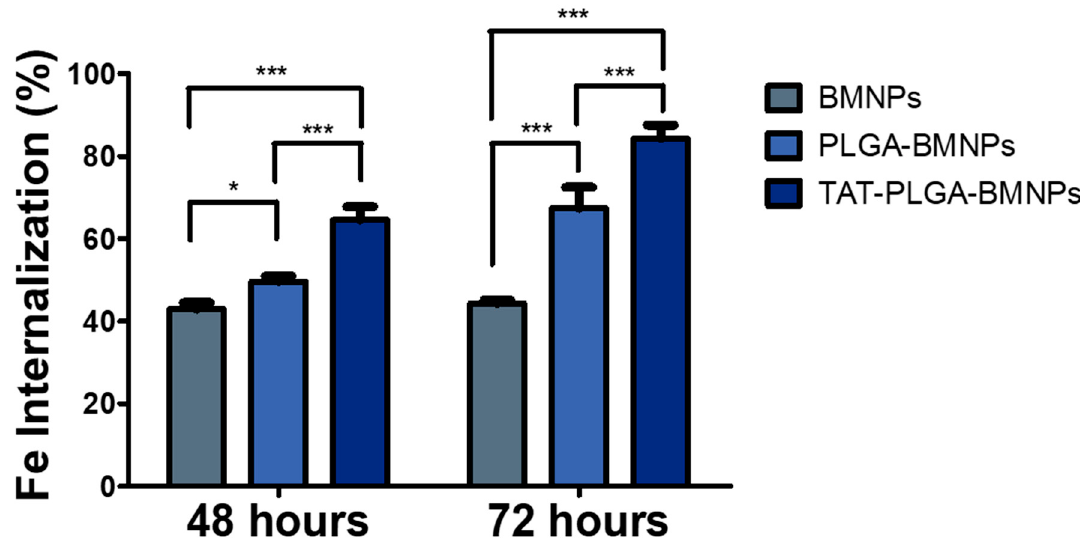
Figure 4. Quantitative analyses of BMNPs internalization in U87MG. Experiments were conducted twice in triplicates. Statistical differences between the treatments were considered significant when p values were p < 0.05 (*), p < 0.001 (***).